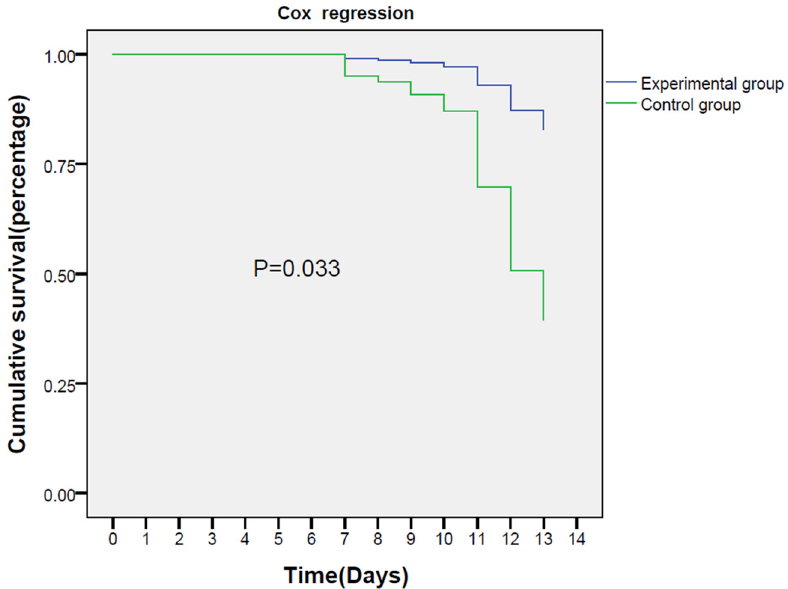
Figure 2: Cox regression.